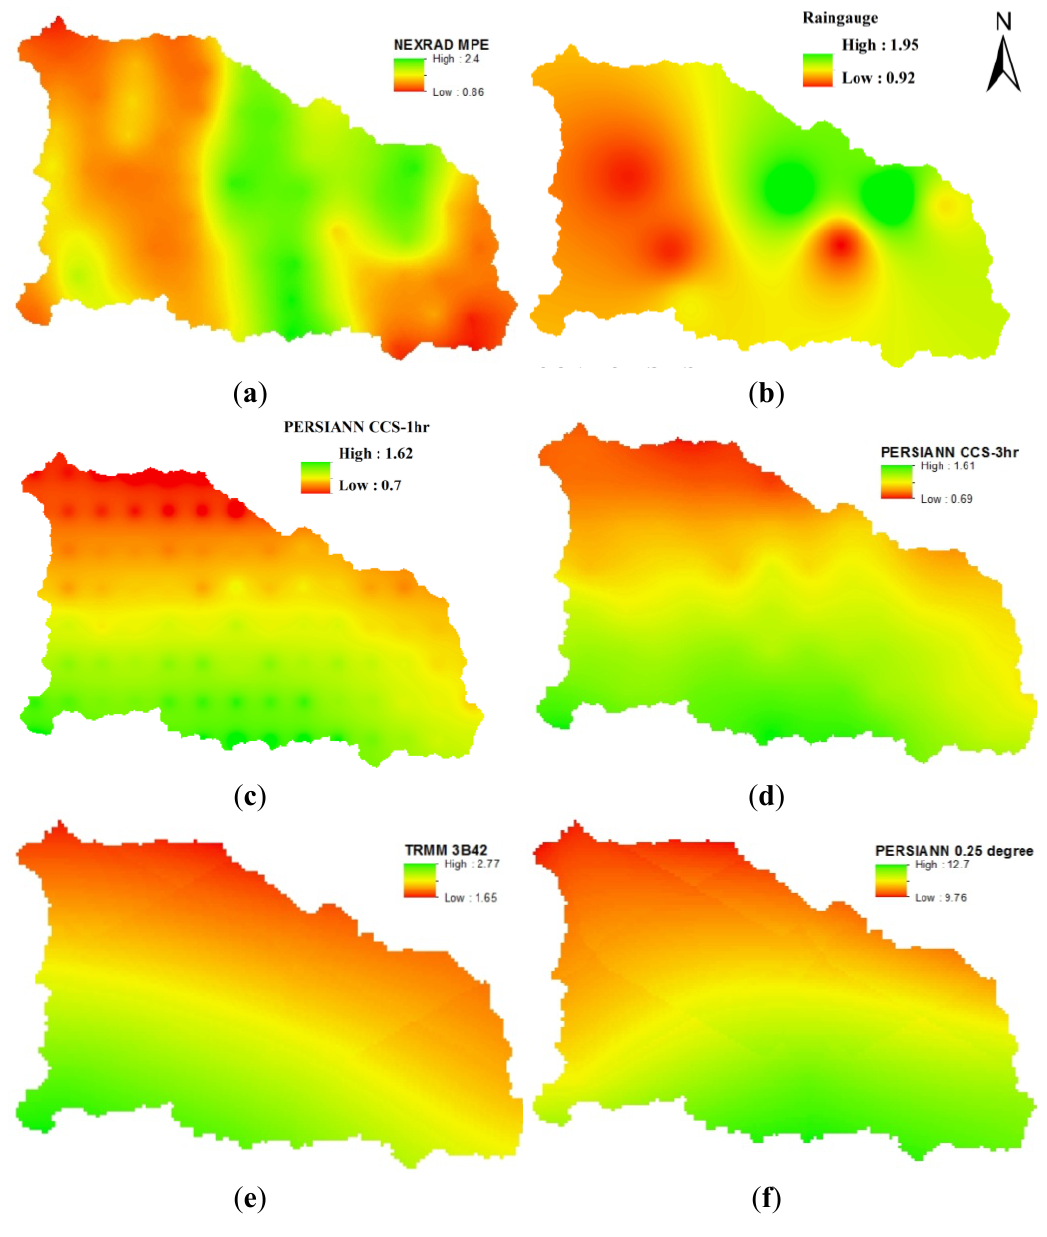
Figure 8. Average precipitation distribution for different precipitation products for the July 2007 event: ( a ) radar; ( b ) raingauges; ( c ) PERSIANN CCS-1hr; ( d ) PERSIANN CCS-3hr; ( e ) TRMM 3B42V7; ( f ) and PERSIANN 0.25